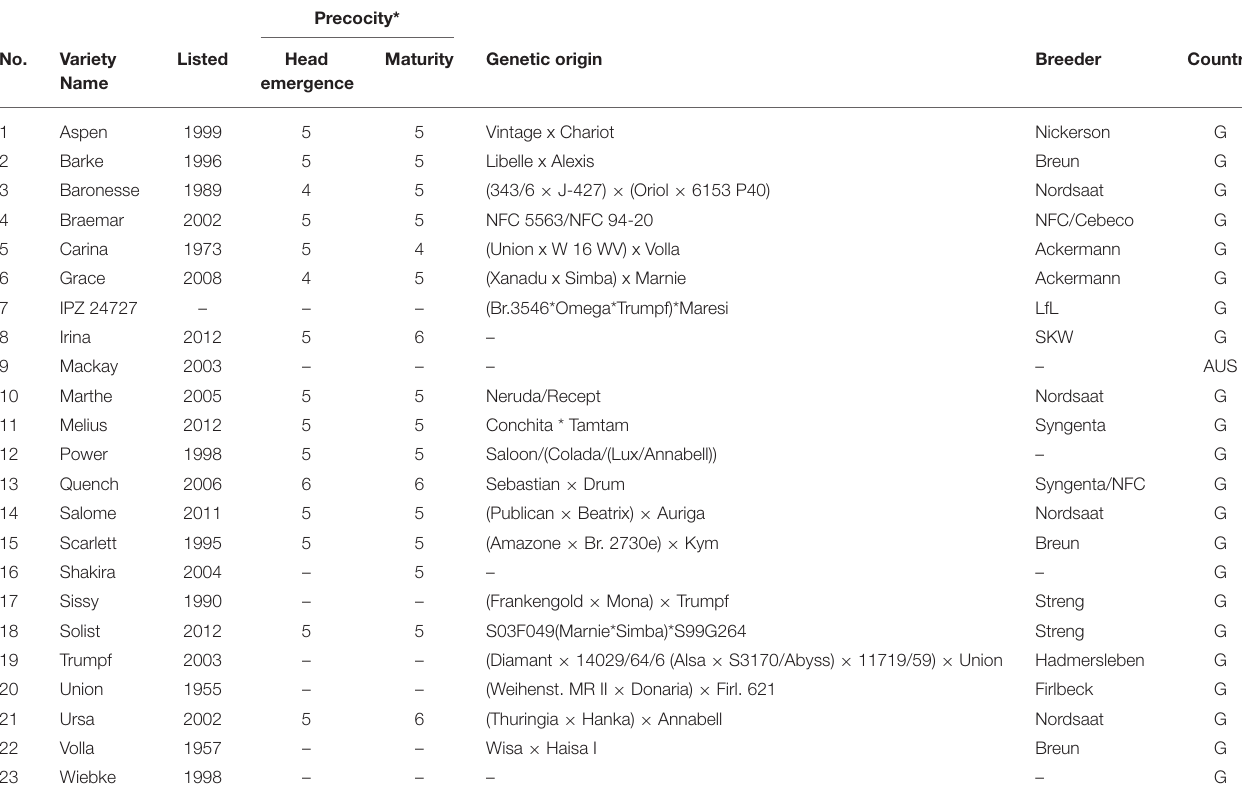
TABLE 1 | Spring malting barley varieties in 2014 and 2015 showing the name, year of release, precocity, genetic origin, breeder and country of origin (G-Germany,